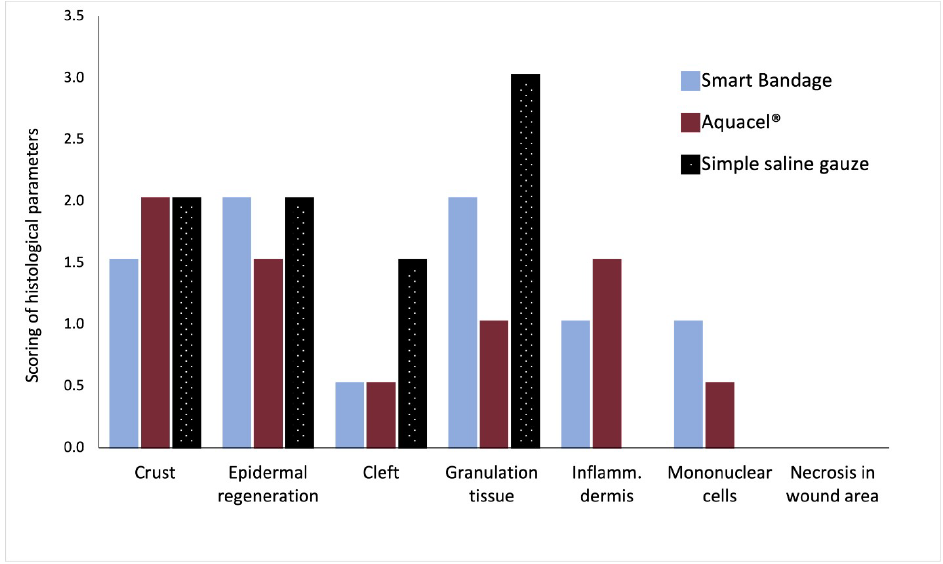
Figure 3. Scoring of tissue healing parameters by an independent pathologist. A total average score of n = 6 analyzed burns; Smart Bandage (INTELIGELS Ltd. Hoshaya, Israel) = 8, Aquacel ® = 7, simple saline gauze = 8.5 (see Appendix Table A3).